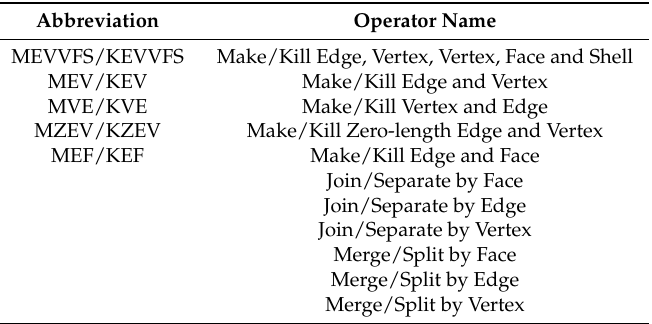
Table 1. A set of Euler operators and extended Euler